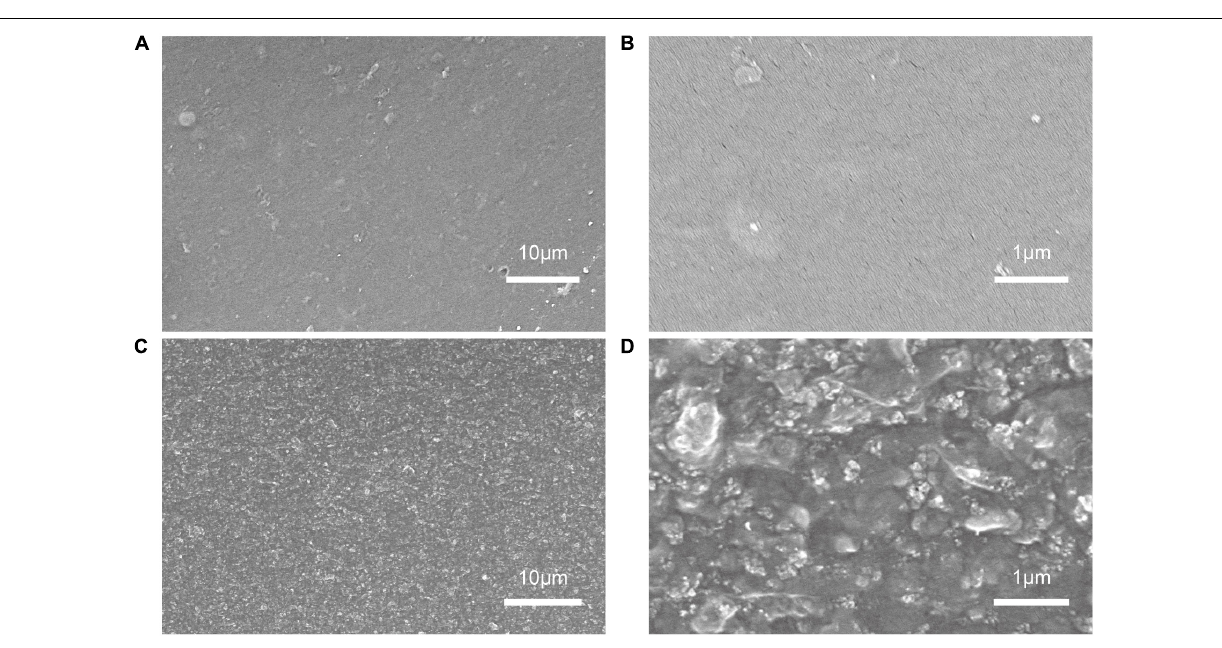
FIGURE 2 | The surface morphology of the electrode film at different magnification. (A,B) The PEDOT:PSS electrode film; (C,D) The 20% CCZ8/P.P electrode